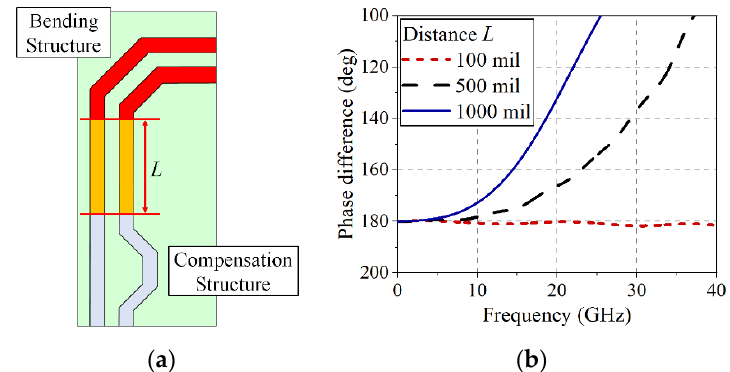
Figure 3. ( a ) Compensation structure located at a distance ( L ) from the bent DL, ( b ) phase difference between the two DL lines after applying the compensation structure (path difference of 30 mil, DL linewidth of 10 mil, and gap width of 5 mil with a 5 mil FR-4 substrate).